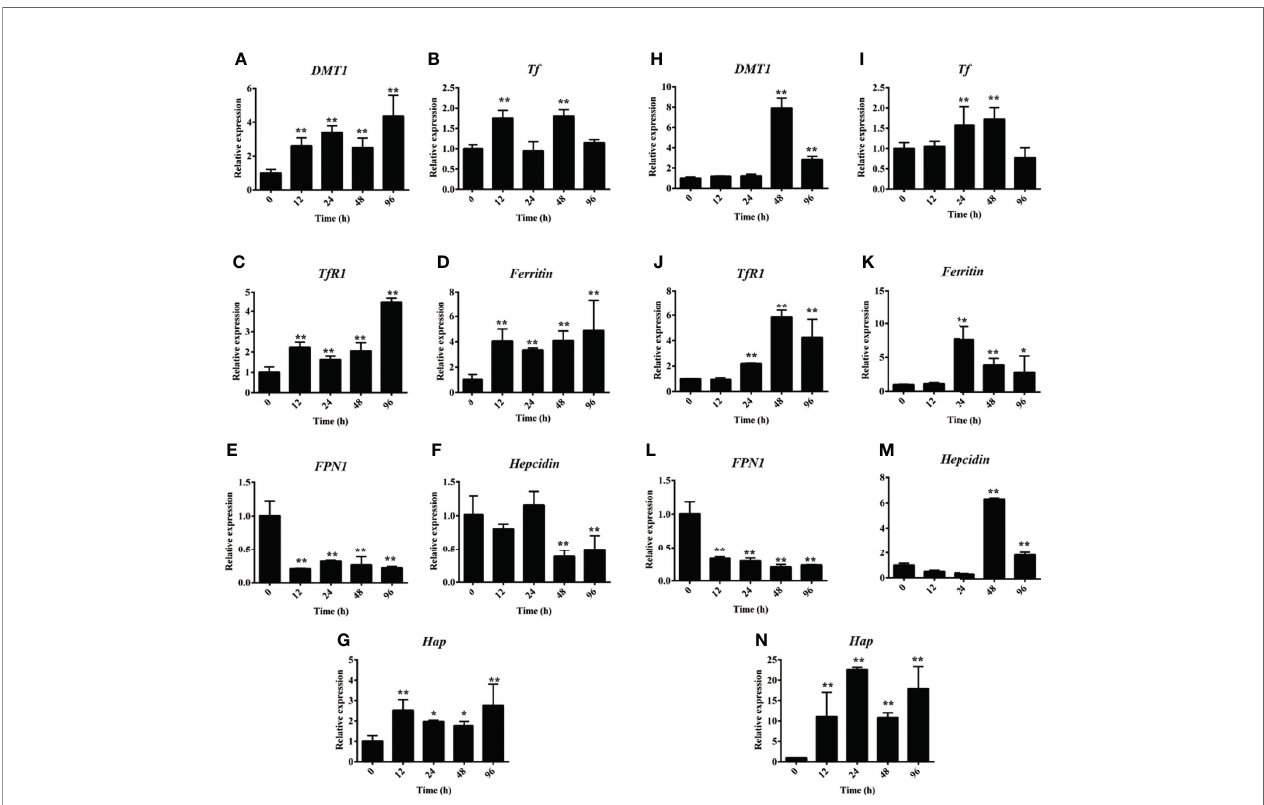
FIGURE 3 | Hemolysis activated the iron metabolism-related genes. (A – G) Phenylhydrazine (PHZ)-induced hemolysis activated the expressions of iron metabolism- related genes, including DMT1 (A) , Tf (B) , TfR1 (C) , ferritin (D) , FPN1 (E) , hepcidin (F) , and Hap (G) , at different time points in the middle kidney. (H – N) PHZ-induced hemolysis activated the expressions of iron metabolism-related genes, including DMT1 (H) , Tf (I) , TfR1 (J) , ferritin (K) , FPN1 (L) , hepcidin (M) , and Hap (N) , at different time points in the middle kidney. * p < 0.05; ** p < 0.01 (Student ’ s t -test). Data represent the mean ± SD of three independent